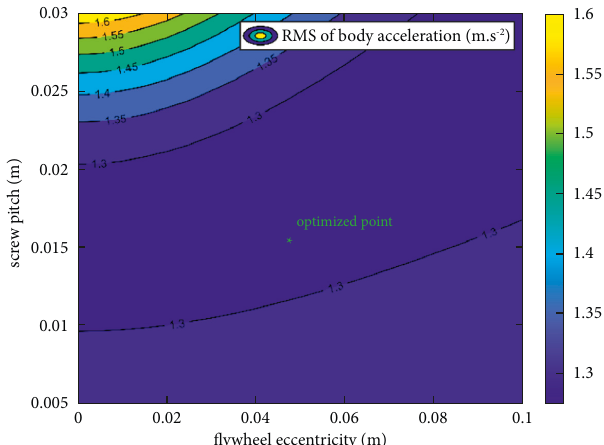
Figure 11: The change of body acceleration subject to the change of flywheel and screw pitch in the series model.